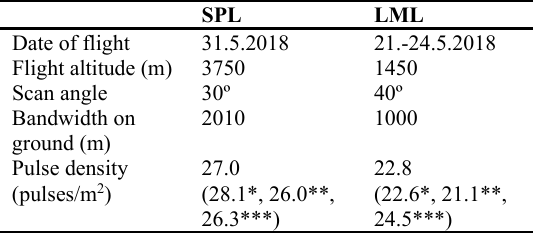
Table 2. Features for SPL (Leica’s SPL100) and Riegl linear-mode laser (LML) scanning data with the achieved point density (points/m 2 ) overall, and among plots with specific species